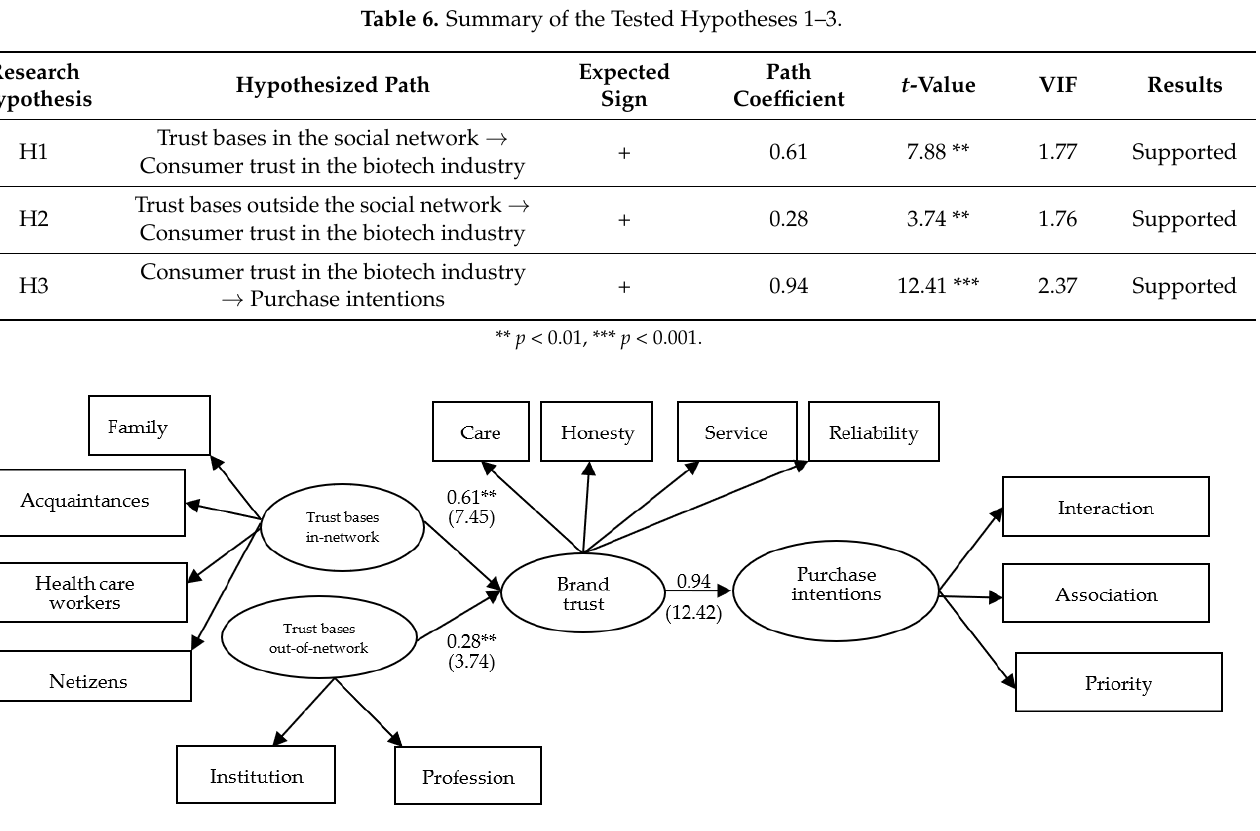
Figure 2. Structural equation model results of this study. Note: Standardized coefficients are outside the parentheses and t -values are inside the parentheses (Note: ** p < 0.01, *** p < 0.001).